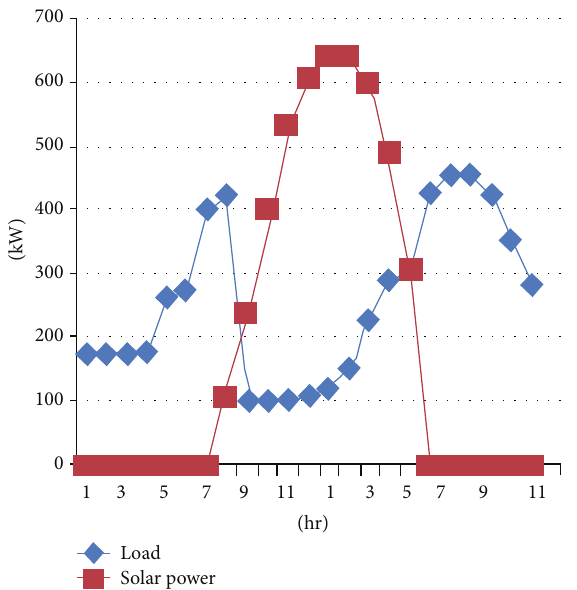
Figure 5: Solar power and load for